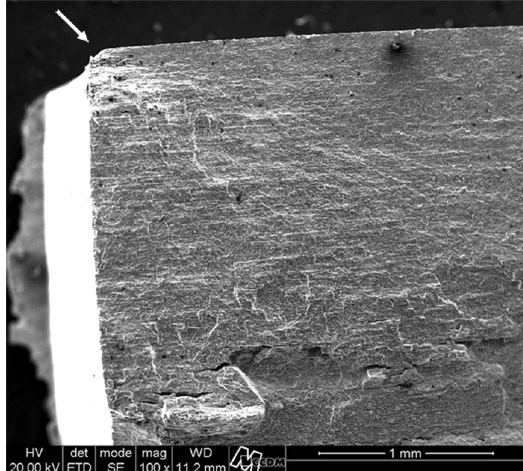
Figure 6. SEM micrograph of the fatigue initiation region of a reference sample. The arrow points at the crack initiation at the edge.